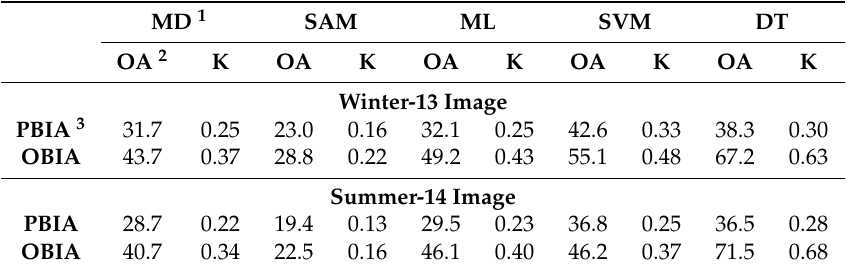
Table 4. Classification accuracies of landforms in winter and summer images using different classification